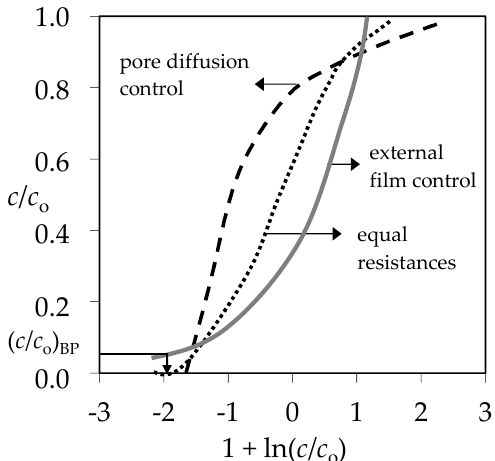
Figure 11. The graphical dependence of effluent and influent solute concentrations ratio versus 1 + ln( c / c o ) [60]. Note: ( c / c o ) BP represents the breakthrough point.